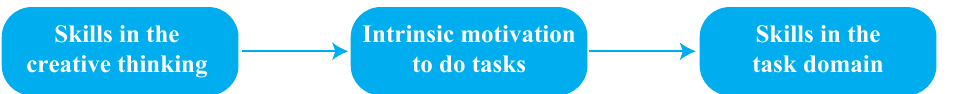
Figure 1: Theoretical framework of workplace innovation “Stages of Creative